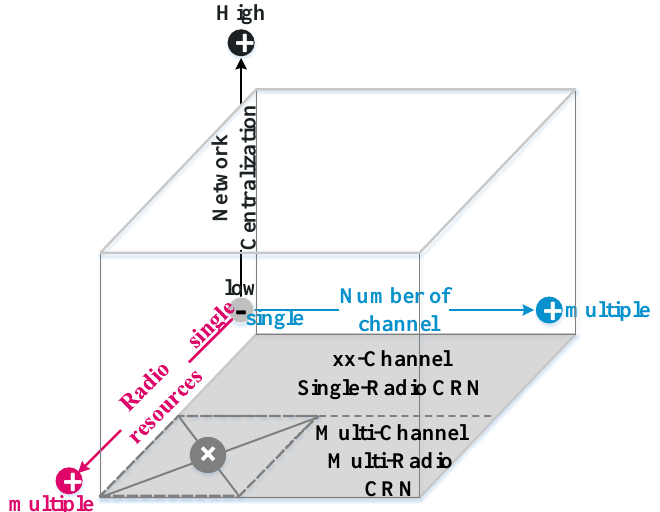
Figure 1. The spectrum assignment of the multi-hop cognitive radio network (CRN) segmented into four parts across three